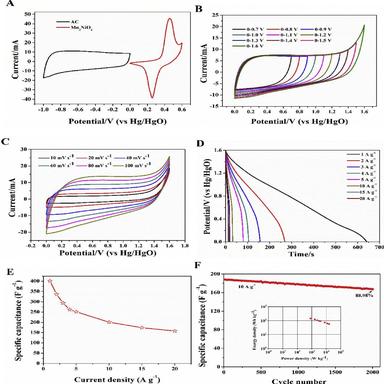
(A) CV curves of the MnNi2O4 and AC electrodes at a scan rate of 50 mV s1 in a three-electrode system. (B) CV curves of the MnNi2O4//AC hybrid supercapacitor measured at different potential windows with a scan rate of 50 mV s1 . (C) CV curves of the MnNi2O4//AC hybrid supercapacitor at different scan rates. (D) GCD curves of the MnNi2O4//AC hybrid supercapacitor at different current densities. (E) Specific capacitances of the MnNi2O4//AC hybrid supercapacitor at different current densities. (F) Cycling perf